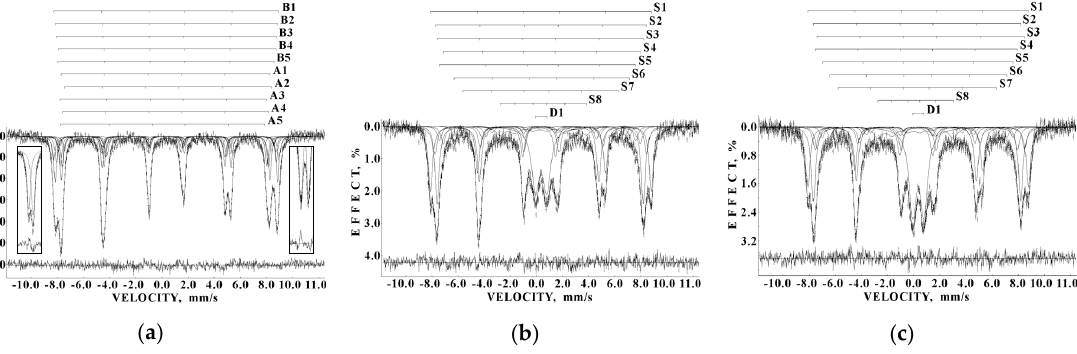
Figure 57. Mössbauer spectra of NiFe 2 O 4 samples N1 ( a ), N2 ( b ) and N3 ( c ) measured at 295 K in 4096 channels and converted into the 1024 ‐ channel spectra. Indicated components are the results of the best fits (A1–A5 and B1–B5 are the magnetic sextets related to the (A) and [B] sites with differ ‐ ent 57 Fe local microenvironments, respectively; S1–S8 are the magnetic sextets, D1 is a paramag ‐ netic doublet). The differential spectra are shown on the bottom. Inserts in the N1 spectrum ( a ) demonstrate misfits for the outer sextet peaks for the fit using the conventional model with two magnetic sextets assigned to the (A) and [B] sites only. Adapted from Ref. [83] with permission from Springer Nature: Hyperfine Interactions, “The milling effect on nickel ferrite particles studied using